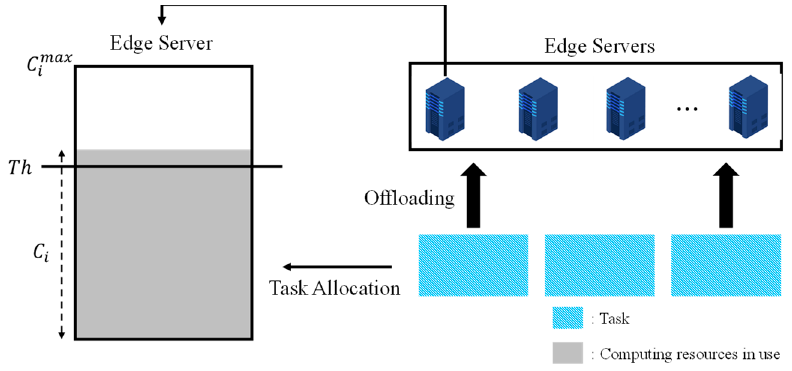
Figure 2. Operation of the proposed scheme.